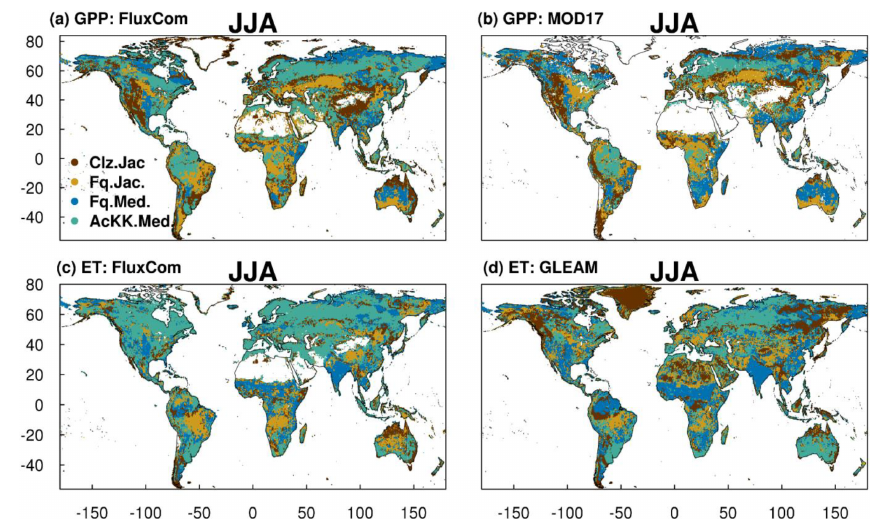
Figure 6. Colours indicate the JULES model configuration that gives the lowest RMSE compared to either the (a) FluxCom and (b) MOD17 global GPP (gCm 2 d − 1 ) products or (c) FluxCom and (d) GLEAM global ET (mmd − 1 ) products for JJA over the period 2002 to 2012. Actual RMSE values shown in Figs. S12 and